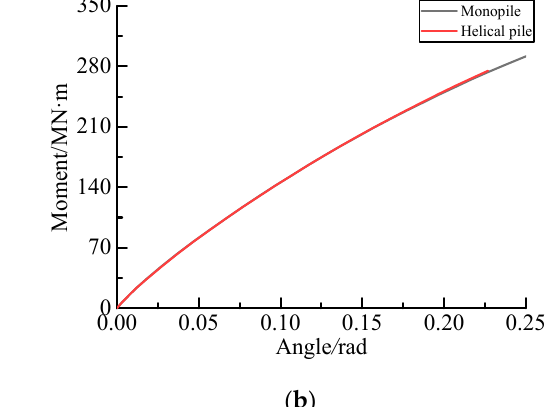
Figure 4. Horizontal and moment capacity of helical pile and monopile. ( a ) Horizontal capacity; ( b ) Moment capacity.